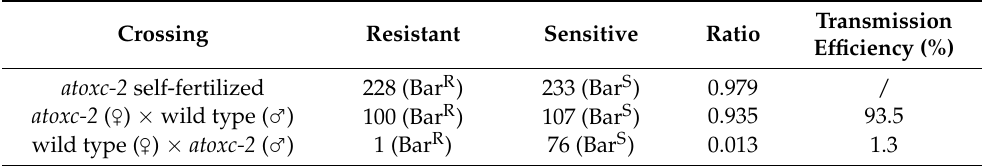
Table 1. T-DNA transmission analysis of atoxc-2 .